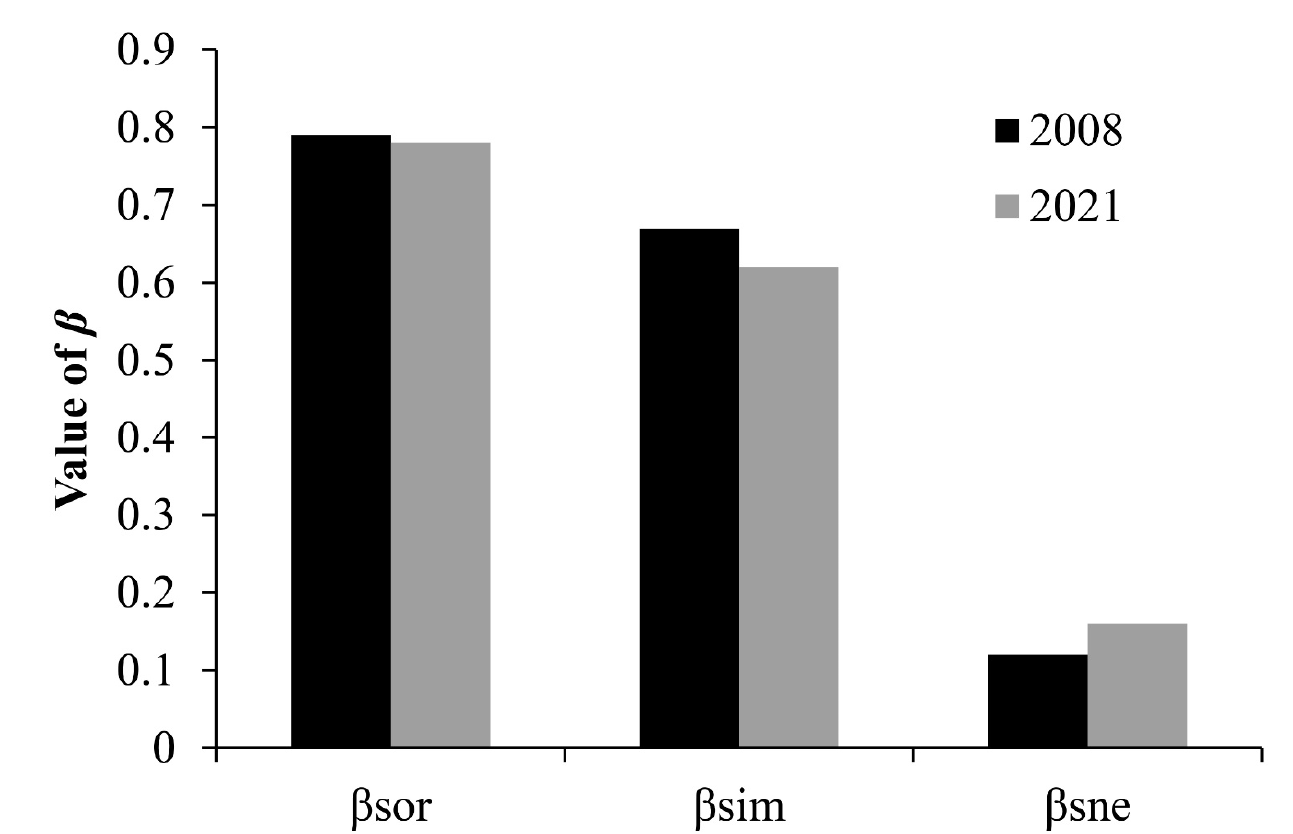
Figure 3. Fish species compositional dissimilarity for 2008 and 2021, quantified by the Sørensen dissimilarity index ( β sor ), its spatial turnover component ( β sim ), and its nestedness component ( β sne ), in the Lushan National Nature Reserve.